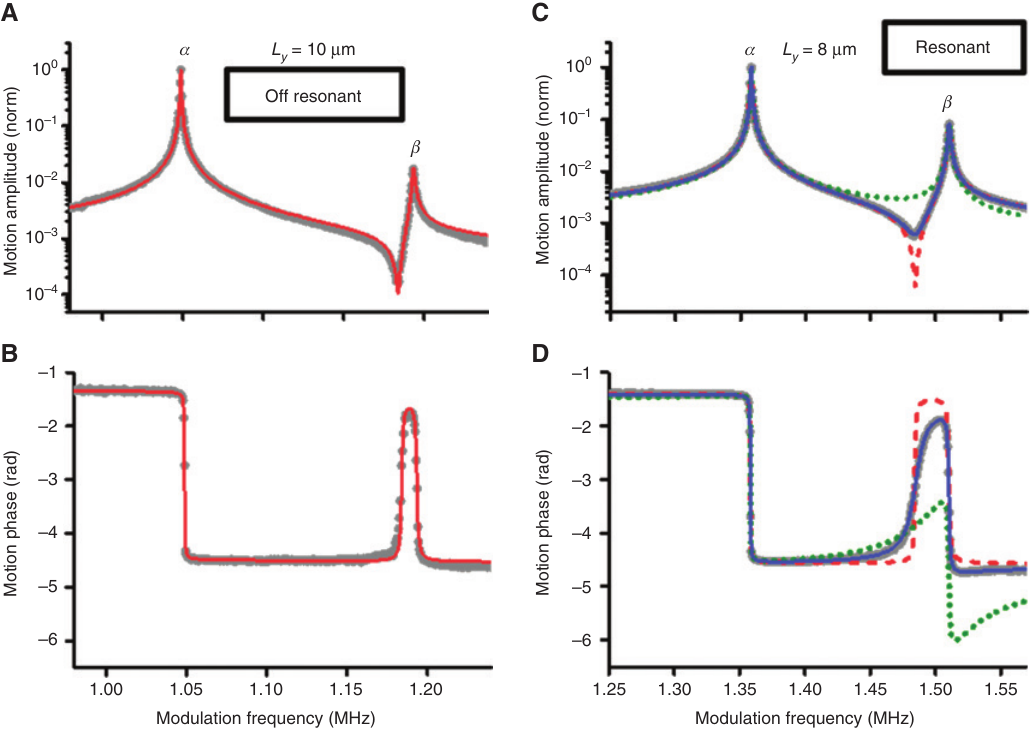
Figure 2: Mechanical response for structures with various detuning from the incident THz beam. (A and B) Amplitude and phase of forced mechanical oscillations of the mechanical beam, for a non-resonant DSR having L dots: scan data. Red solid lines: amplitude and phase calculated from the model of Eq. (1) with A modes. (C and D) Amplitude and phase of forced mechanical oscillations of the beam, for a resonant DSR having L data. Red dashed lines: amplitude and phase calculated from the model of Eq. (1) with A Green dotted lines: amplitude and phase calculated from Eq. (1) with A driven β mode. Blue solid lines: amplitudes and phase calculated from Eq. (1), corresponding to a thermally driven α mode and a β mode which is 26% Coulomb